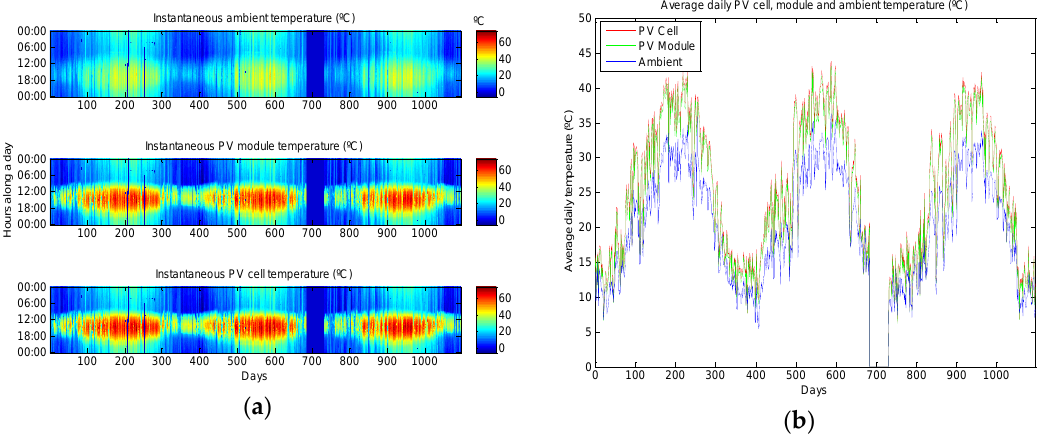
Figure 4. Registered ambient and module temperature, and calculated cell temperature registered from 1 January 2011 to 31 December 2013: ( a ) instantaneous values, during 24 h a day; and ( b ) average daily values.